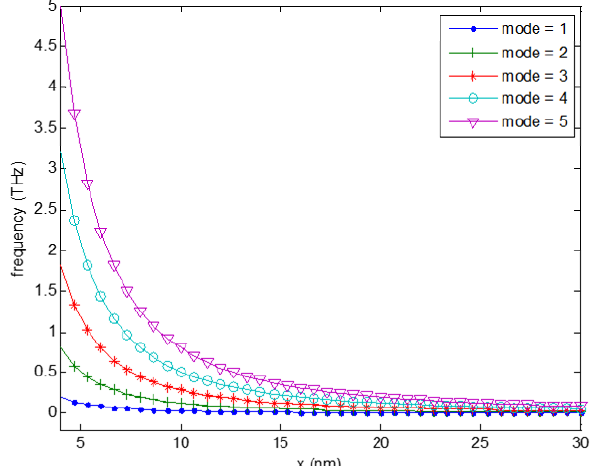
Figure 8. Effect of modal number on the